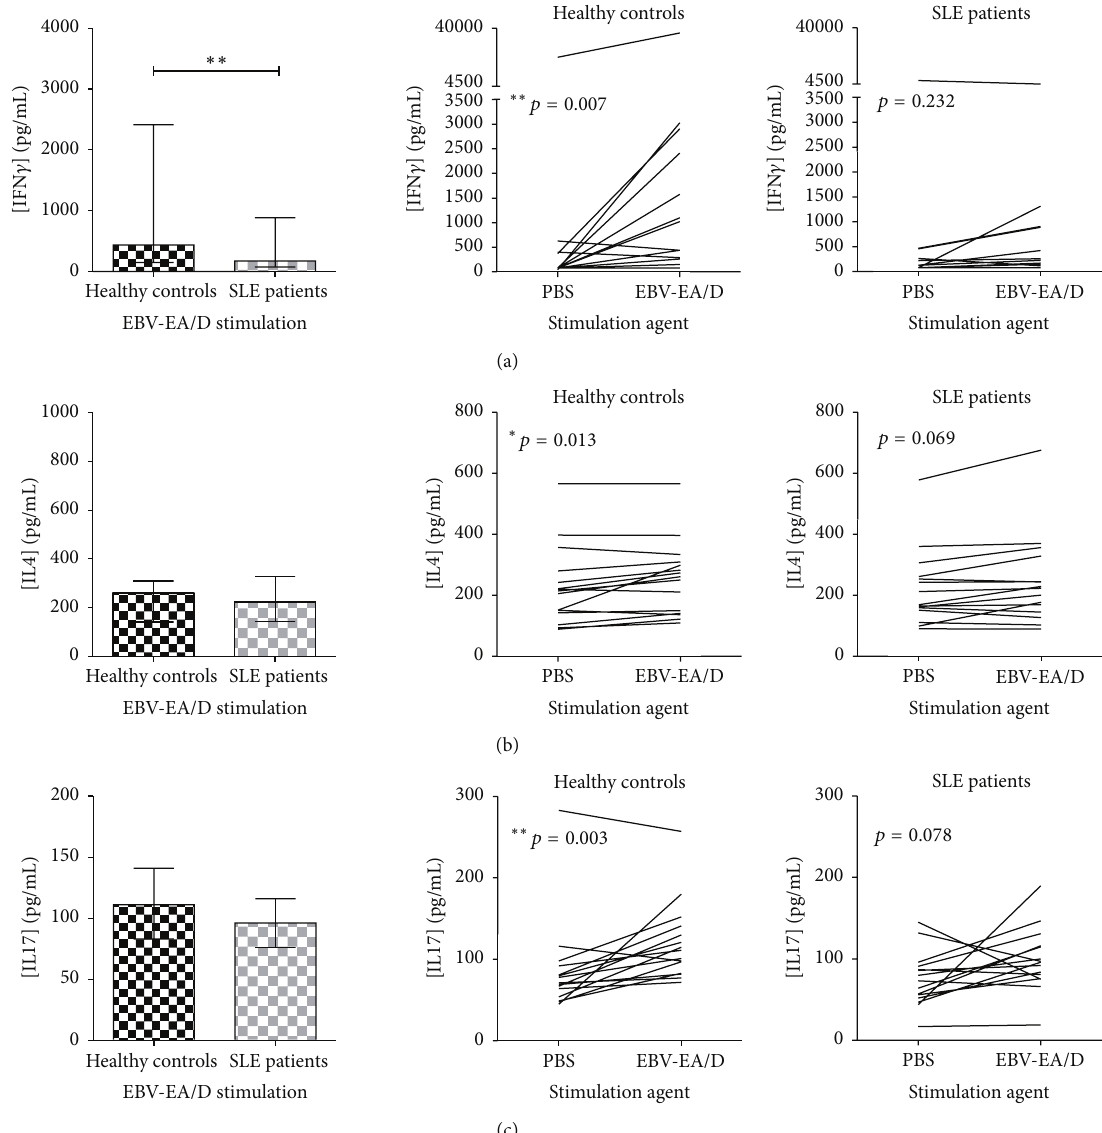
Figure 4: Impaired induction of IFN 𝛾 (a), IL4 (b), and IL17 (c) in SLE patients upon EBV-EA/D stimulation. IFN 𝛾 (a), IL4 (b), and IL17 (c) quantified in dried blood spot samples from SLE patients (with normal lymphocyte levels, 𝑛 = 15 ) and sex- and age-matched HCs ( 𝑛 = 15 ) by multiplexed Luminex assay with addition of HBR+. Left: cytokine concentrations (pg/mL) in SLE patients and HCs upon EBV-EA/D stimulation. Data are presented as median with interquartile range. 𝑝 values for comparison of SLE patients and HCs are 0.005, 0.443, and 0.191 in (a), (b), and (c), respectively. Right: induction of cytokines (pg/mL) from basic levels (PBS stimulation) by EBV-EA/D stimulation in SLE patients and